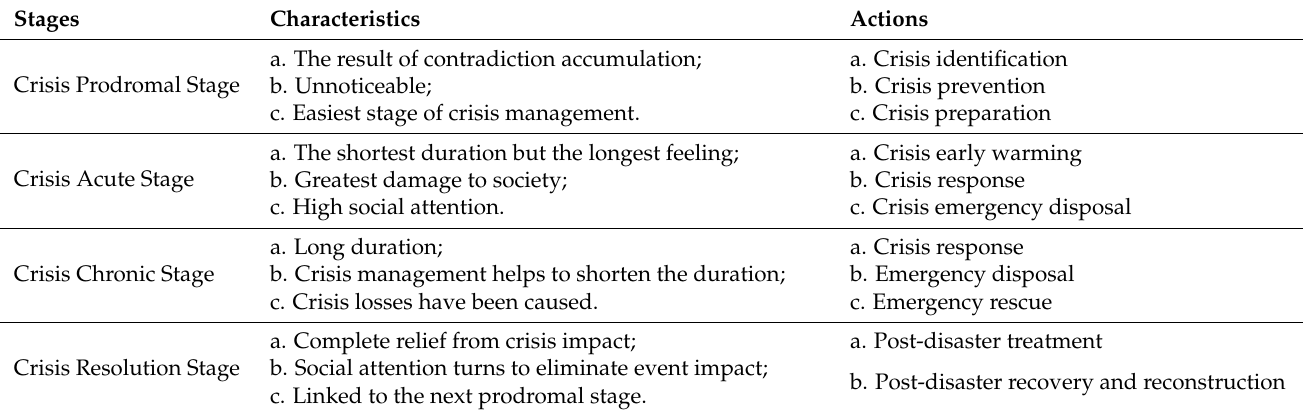
Table 2. Periodicity and the characteristics of the stages of crisis events.